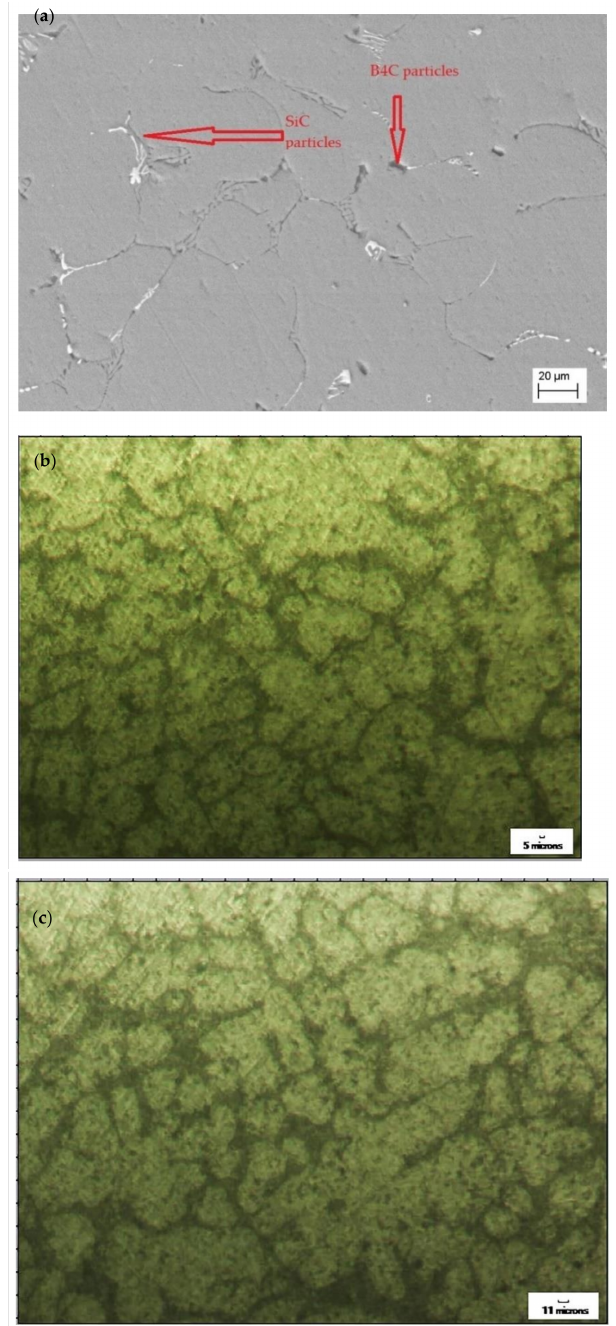
Figure 2. Figures for displaying the microstructure of the composite: ( a ) SEM image of the specimen; ( b ) microscopic image with 100 × magnification; and ( c ) microscopic image with 200 ×